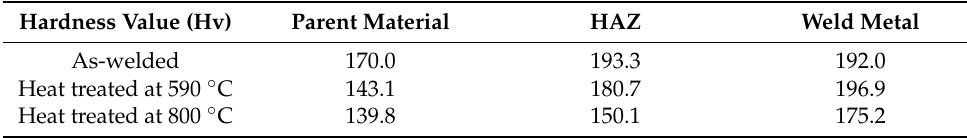
Table 4. Vickers hardness